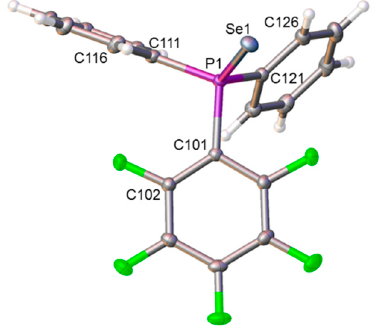
Figure 4. Molecular structure of compound 4 . Selected interatomic distances (Å): P1 − Se1 2.1047(3), P1 − C101 1.8346(11), P1 − C111 1.8141(12), and P1 − C121 1.8080(12).